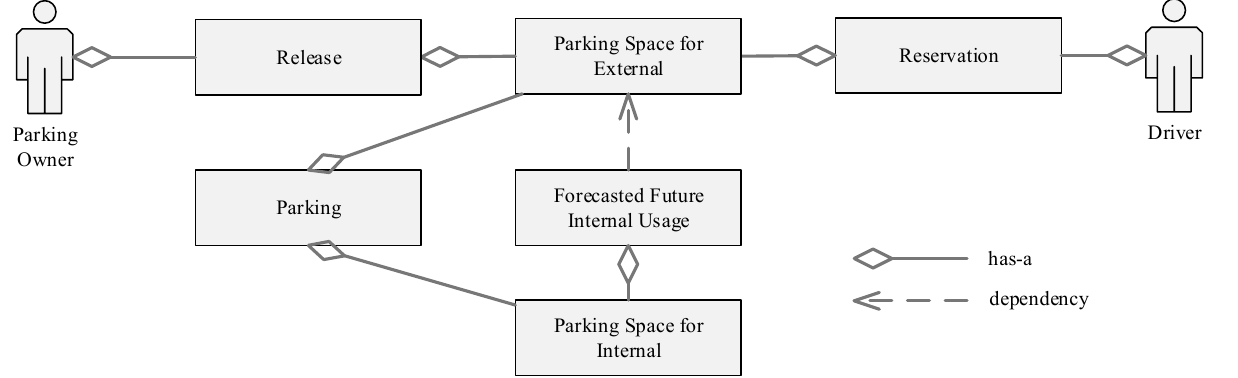
Figure 5. Domain modeling diagram describing the requirement needs.